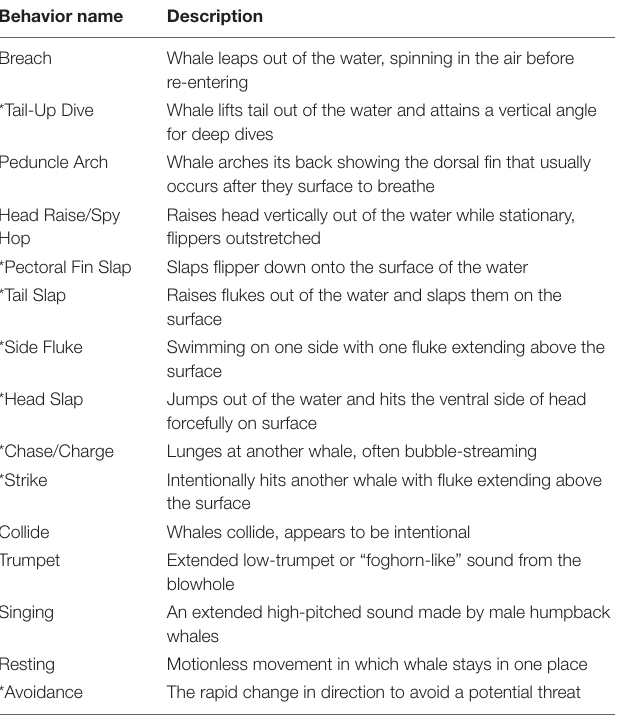
TABLE 1 | Description of behavior categories for humpback whale behaviors (based on descriptions by: Glockner-Ferrari and Ferrari (1984) and Gabriele (1992) (adapted from Bauer, 1986; Helweg, 1989; Corkeron, 1995; Darling and Nicklin,